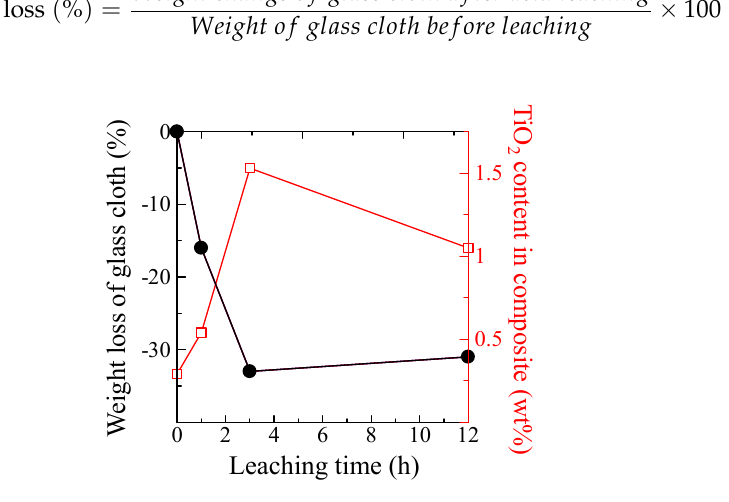
Figure 4. TiO 2 content in the TiO 2 -coated porous glass cloth (open squares) and weight loss of the porous glass cloth (filled circles) versus the acid leaching time.